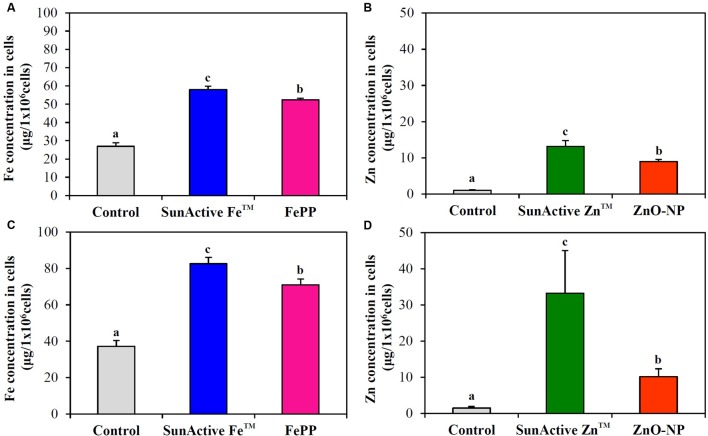
Cellular uptake of
(A,C) SunActive FeTM and (B,D) SunActive ZnTM in (A,B) Caco-2 cells and in (C,D) INT-407 cells after treatment for 6 h, measured by ICP-AES. FePP and ZnO-NPs were used as counterpart materials for SunActive FeTM and SunActive ZnTM, respectively. Mean values with different letters (a,b,c) in the same figure indicate significant differences among untreated control, SunActiveTM product, and its counterpart material (p < 0.05).